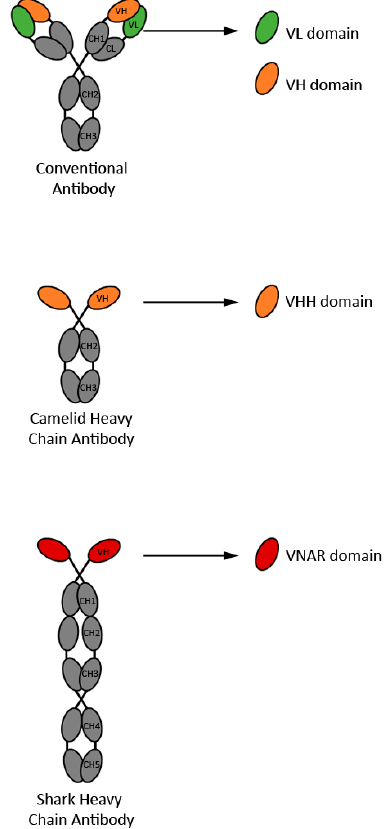
Figure 1. Schematic representation of the four types of sdAbs described in the current review. Antibody constant domains are in grey, whereas antibody variable domains from which sdAbs are derived are in